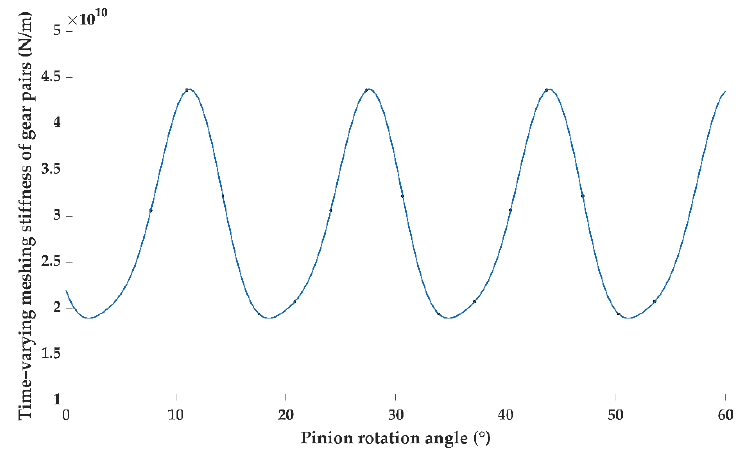
Figure 4. TVMS curve.